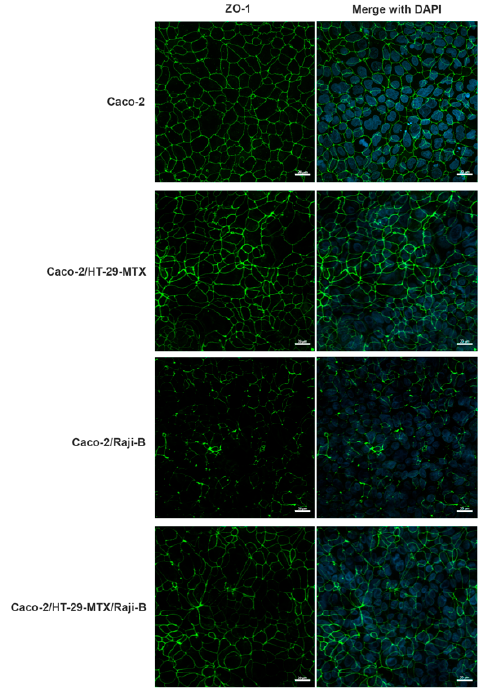
Figure 1. Analysis of ZO-1 expression (green) by confocal laser scanning microscopy (CLSM) in different (co)-culture conditions after 21 days of culture. Caco-2 mono-culture; Caco-2/HT29-MTX co-culture; Caco-2/Raji B co-culture; Caco-2/HT29-MTX co-culture; Caco-2/HT29-MTX/Raji B tri-culture. Nuclei were counterstained with DAPI (blue). Bars, 20 µ m.